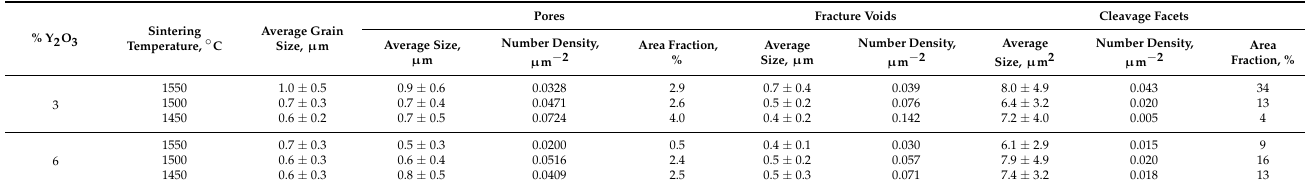
Table 1. Parameters of microstructure and fracture surface of the ceramics.